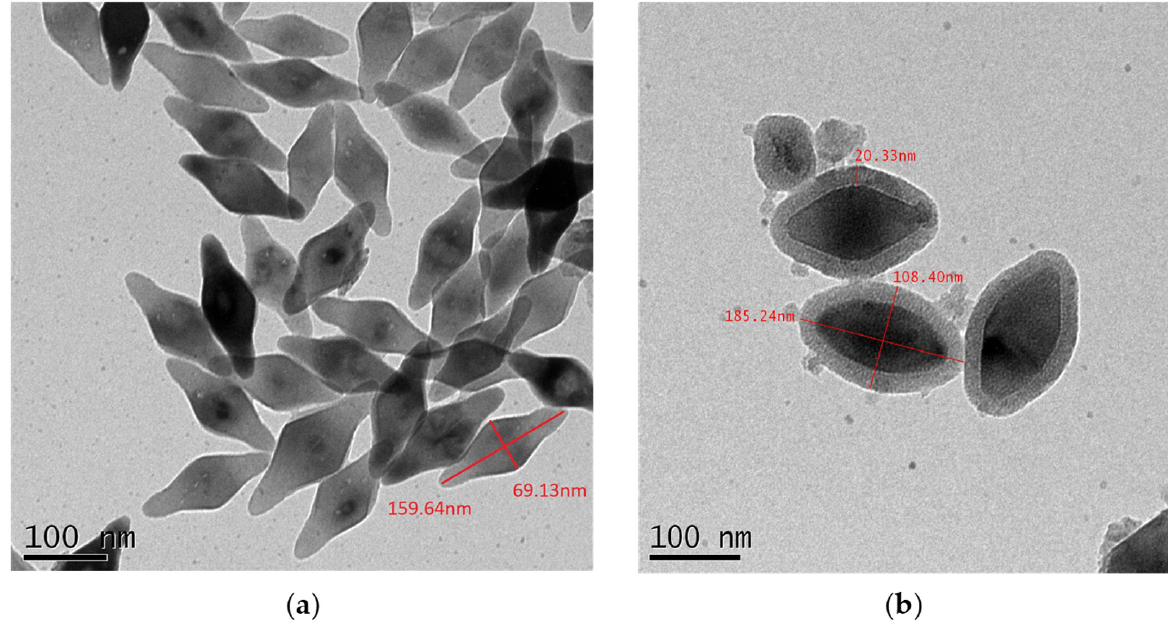
Figure 2. TEM images of LiYF 4 :Yb 3+ 0.25 ,Ho 3+ 0.01 @LiYF 4 :Yb 3+ 0.2 UCNPs. ( a ) Ligand-free nanoparticles; ( b ) mSiO 2 -coated nanoparticles.